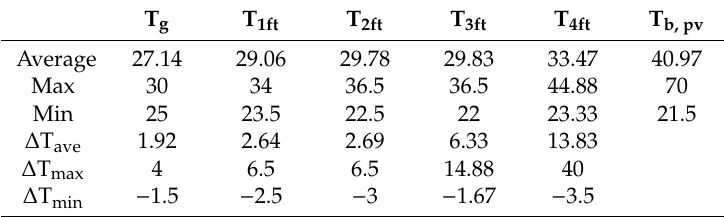
Table 1. Values of temperature difference, ∆ T, (in °C) based on a 1 foot height distribution. T g T 1ft T 2ft T 3ft T 4ft T b, pv Average